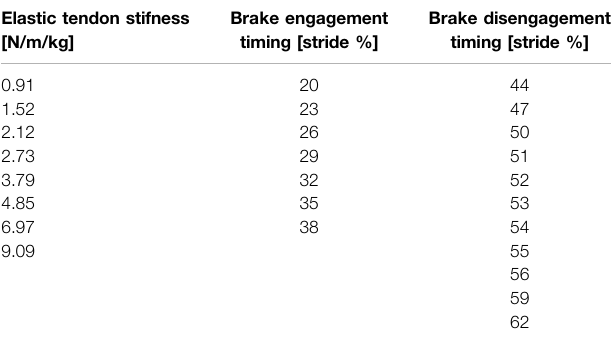
TABLE 1 | Parameter sweep analysis values. One parameter value from each column is chosen to form a parameter triplet. All possible triplets were tested. Elastic tendon stifness Brake engagement [N/m/kg] timing [stride